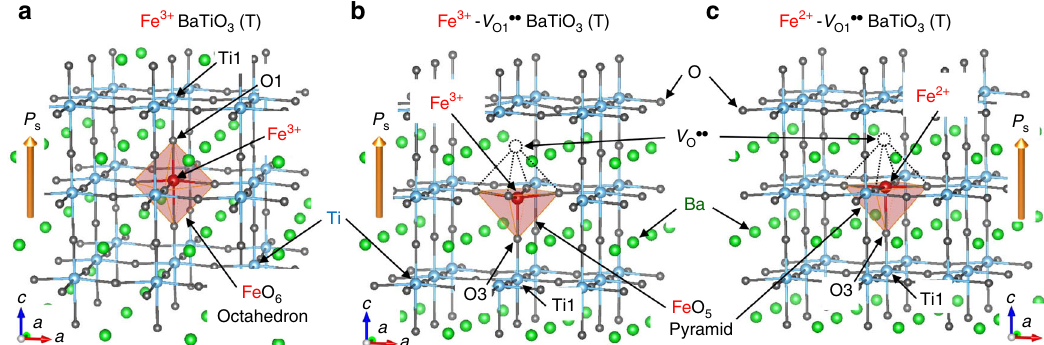
Fig. 3 Crystal structures of tetragonal (T) Fe-BaTiO 3 cells. The crystal structures optimized by density-functional theory (DFT) calculations are displayed for a Ba 27 Ti 26 FeO 81 (Fe 3 + ), b Ba 27 Ti 26 FeO 80 (Fe 3 + - V O1 (cid:129)(cid:129) ), and c Ba 27 Ti 26 FeO 80 (Fe 2 + - V O1 (cid:129)(cid:129) ). The valence states of Fe are controlled by the total number of electrons. The crystal symmetry was converged in tetragonal space group P 4 mm for all the cells, where the spontaneous polarization ( P s ) is parallel to the c axis. O1 and O3 are de fi ned as the fi rst and third nearest-neighbor (NN) oxygen atoms with respect to Fe in the defect-free cell. Ti1 is the fi rst-NN titanium atom with Fe. In the defective cells, an oxygen vacancy ( V O (cid:129)(cid:129) ) is stabilized on the fi rst NN O1 site (see Fig. 2), namely, is present as the associate of Fe 3 + - V O (cid:129)(cid:129) or Fe 2 + - V O (cid:129)(cid:129)